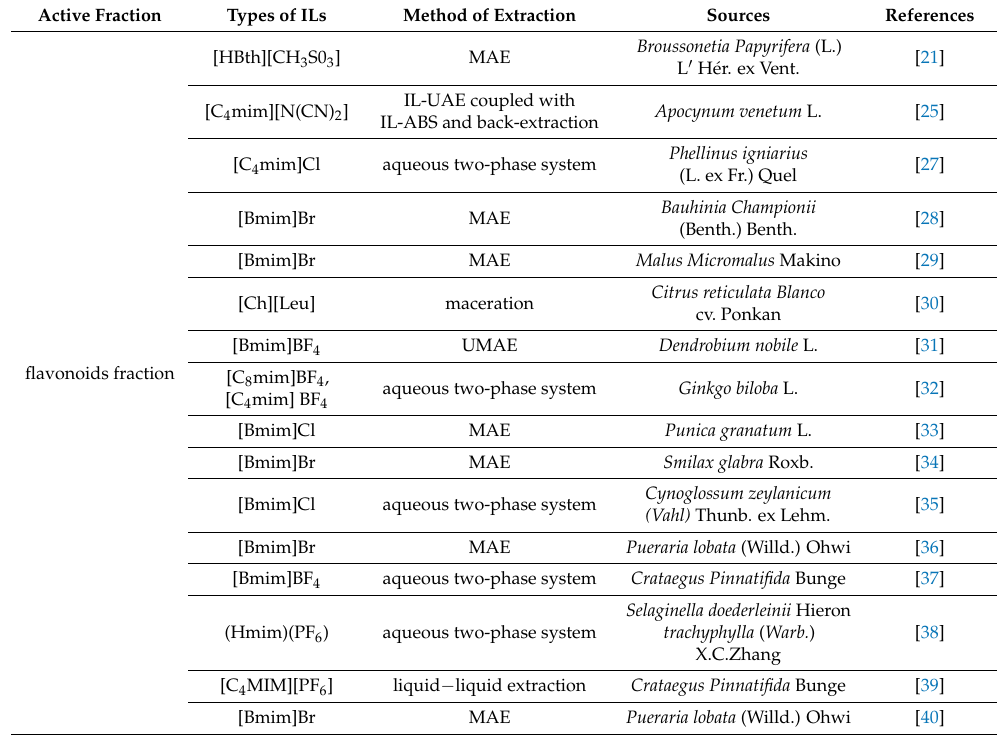
Table 2. The application of ILs on extraction of the flavonoids fraction, and polysaccharides fraction.